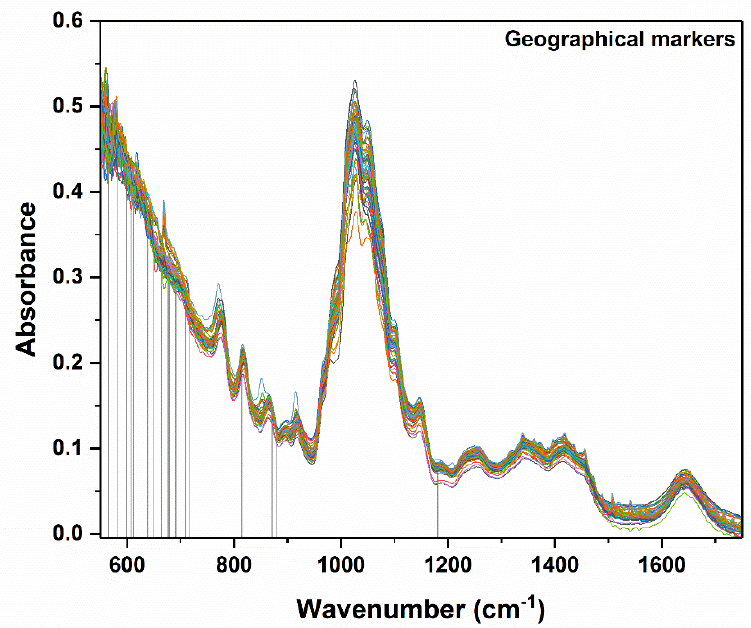
Figure 10. Plotted spectra of all investigated samples (for their differentiation distinct colors were used). The vertical lines marked the spectral points having high differentiation power for the geographical discrimination of the investigated honey samples.